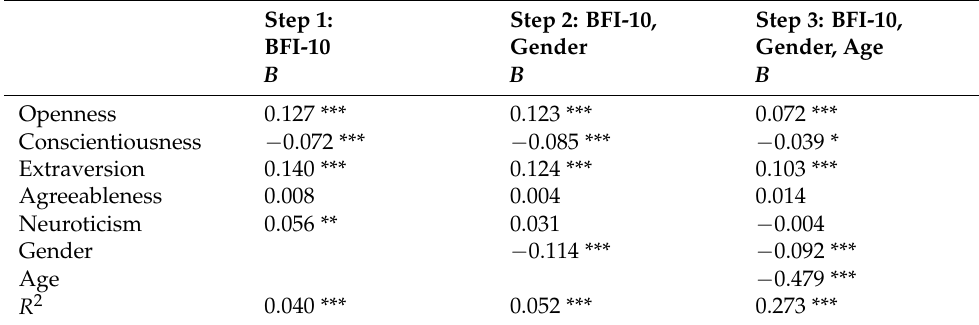
Table 4. Hierarchical regression model exploring how personality factors (BFI-10), gender, and age predict social media usage.